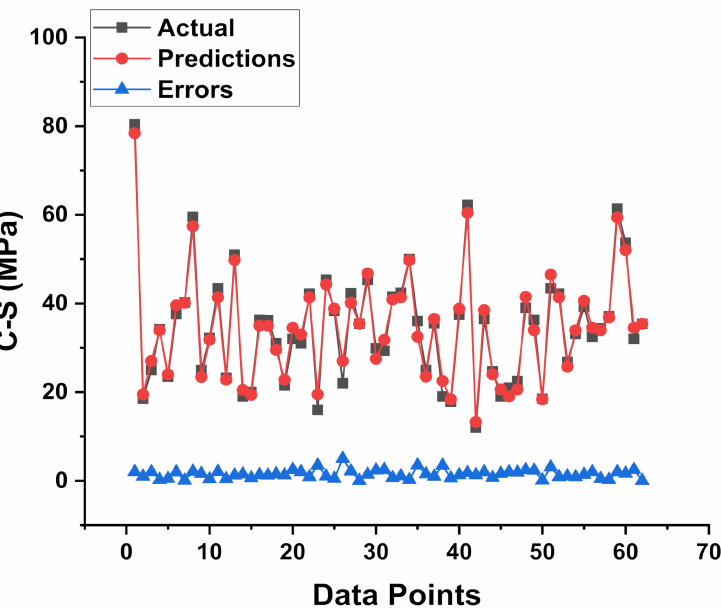
Figure 8. Experimental and predicted dispersal of the results along with the scattering of their errors for the XGB model.